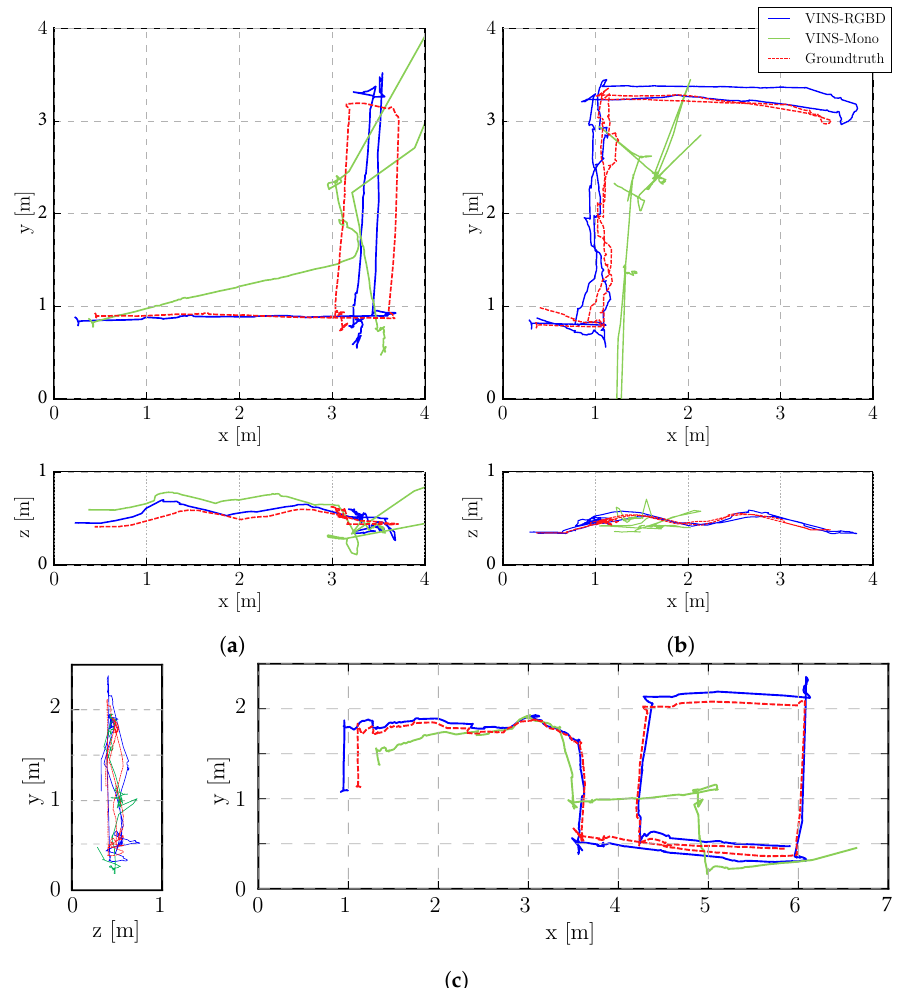
Figure 17. Tracked robot trajectory estimations. Start point on the left for all three experiments. ( a ) Tracked 1: Ground and Up-down Slopes. Top View (top), Side View (bottom); ( b ) Tracked 2: Cross and Up-down Slopes. Top View (top), Side View (bottom); ( c ) Tracked 3: Cross and Up-down Slopes and Ground. Top View (right), Side View